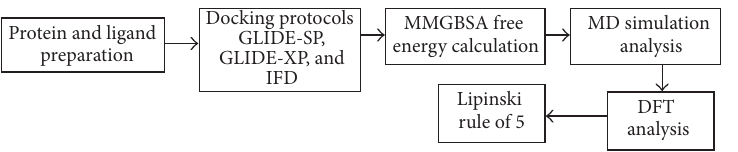
Figure 1: Schematic representation of proposed